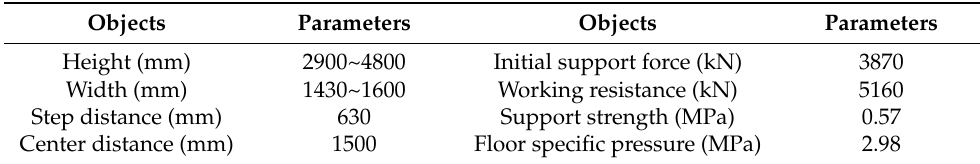
Figure 3. Evaluation index of operating performance.